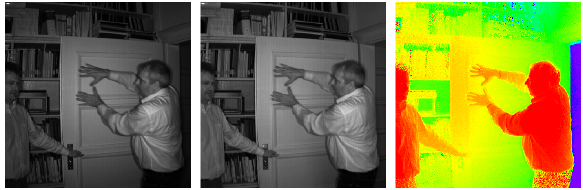
Figure 2: Visualization of the data captured with a PMD[vision] CamCube 2.0: Normalized active intensity image, normalized passive intensity image and range image (from left to right). The range is encoded in terms of a color scale reaching from red (near) via yellow, green, cyan and blue to violet (far).